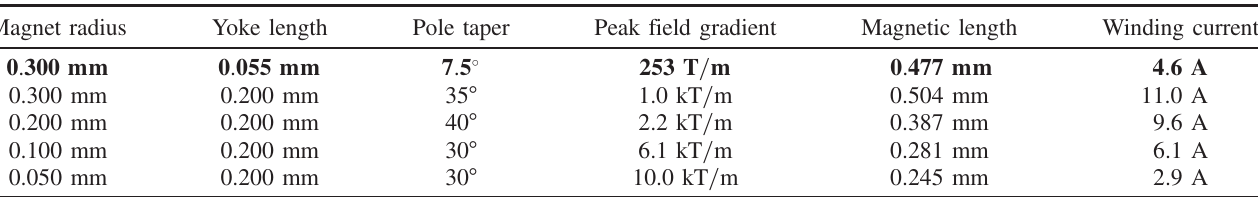
TABLE I. Simulated MEMS quadrupole field parameters in the center of the electromagnet driven to saturation. The prototype quadrupole electromagnet is typeset bold. Pole taper is optimized for each geometry to maximize peak field gradient. Magnet